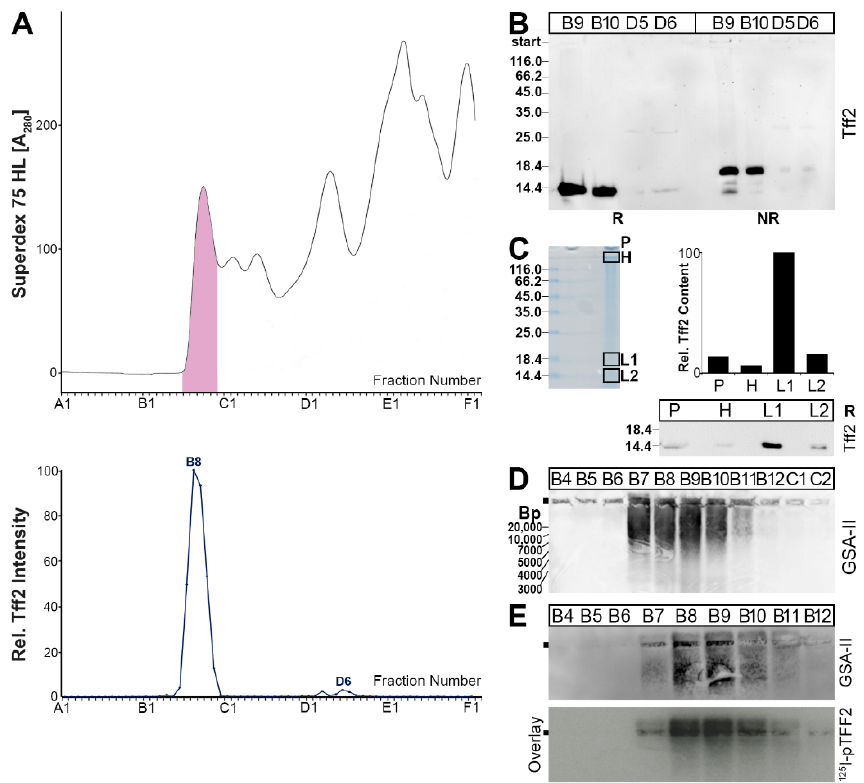
Figure 5. Analysis of a murine duodenal extract (complete duodena from 4 animals). ( A ) Elution profile after SEC on a Superdex 75 HL column as determined by absorbance at 280 nm (PAS-positive mucin fractions: pink). Underneath: Distribution of the relative Tff2 content as determined by Western blot analysis under reducing conditions and semi-quantitative analysis of the monomeric band intensities. ( B ) 15% SDS-PAGE under reducing (R) and non-reducing (NR) conditions, respectively, and Western blot analysis of the high-molecular-mass fractions B9 and B10, as well as the low-molecular-mass fractions D6 and D7 concerning Tff2. ( C ) Non-reducing 15% SDS-PAGE of fraction B8 and Coomassie staining. The high- (H) and low-molecular-mass regions (L1, L2) were cut out, the proteins were eluted, and subjected to reducing SDS-PAGE. Also, the remaining high- molecular-mass sample not entering the gel was removed from the gel pocket (P) and subjected to reducing SDS-PAGE. Western blot analysis concerning Tff2 of P, H, L1, and L2 and relative Tff2 content. ( D ) 1% AgGE and Western blot analysis of the fractions B4–C2 concerning Muc6 (lectin GSA-II). Relative standard: DNA ladder (base pairs). ( E ) 1% AgGE and Western blot analysis of high-molecular-mass fractions B3–B12 of a parallel SEC concerning Muc6 (lectin GSA-II). Shown are also the hybridization signals (autoradiography) obtained after incubating the blot with 125 I-labeled porcine pancreatic TFF2 (pTFF2; overlay assay).